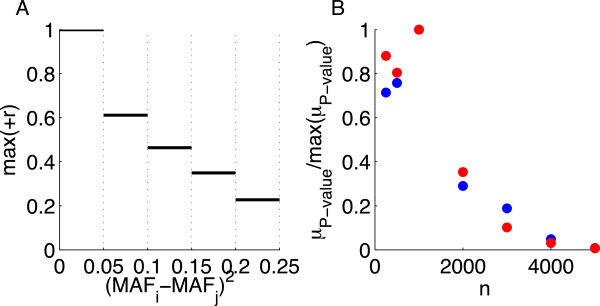
Insensitivity of the selection phase boundary to minor allele frequency (MAF) for chromosome 22. (A) The maximum positive root of the r2 LD measure (+r) as a function of squared MAF difference. The maxima are estimated over bin lengths of 0.05 for SNPs in chromosome 22. (B) The median P -value (μP − value) normalized by the maximum value as a function of sample size for s = 125 from {−1,  1} and h2 = 0.5 for nonzero coefficients sampled from low (blue) or high (red) MAF SNPs on chromosome 22.